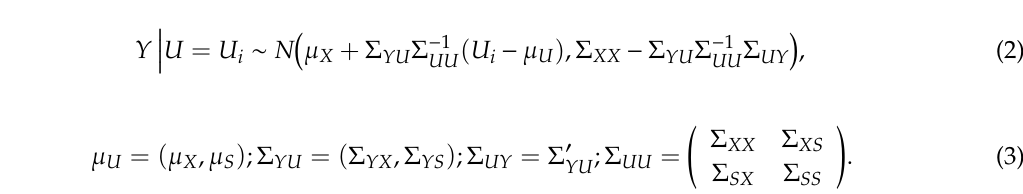
Figure 1. Procedure in applying GADP.